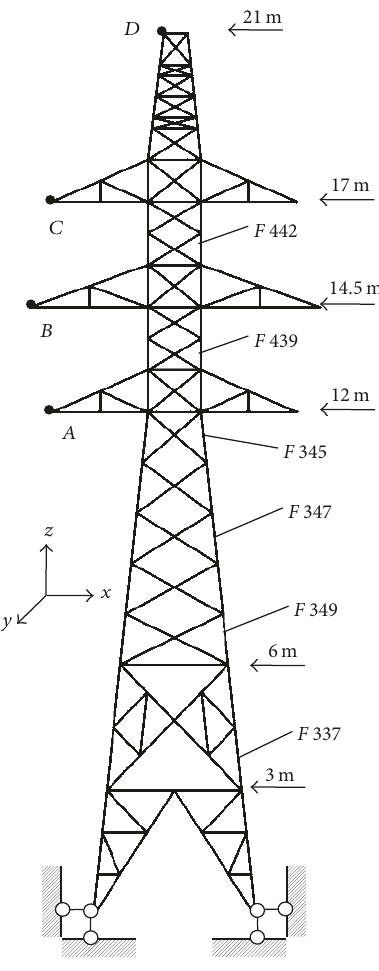
Figure 13: Elevation of the transmission tower.